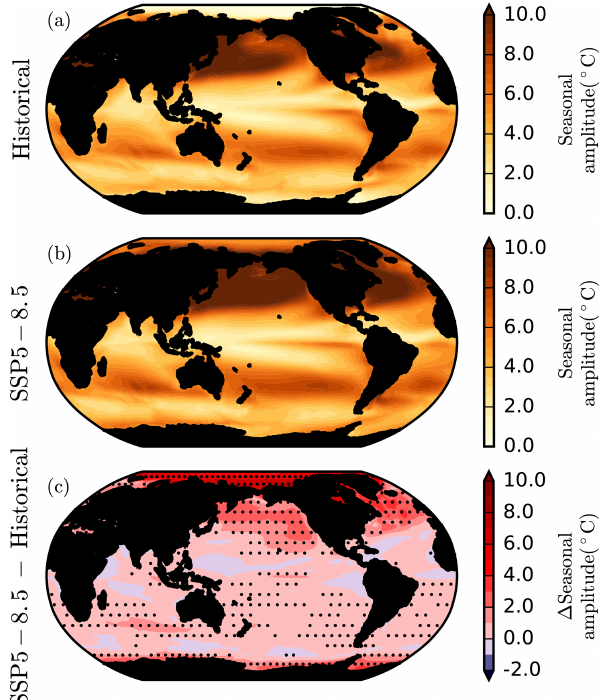
Figure 11. The seasonal amplitude of sea surface temperature. The CMIP6 multi-model mean peak-to-peak seasonal amplitude of sea surface temperature ( ◦ C) in (a) 1995–2014 of the historical sim- ulations, (b) 2080–2099 of the SSP5-8.5 simulations, and (c) the change in seasonal amplitude between the two periods. Stippling designates robustness, as defined by at least 80% model sign agree-